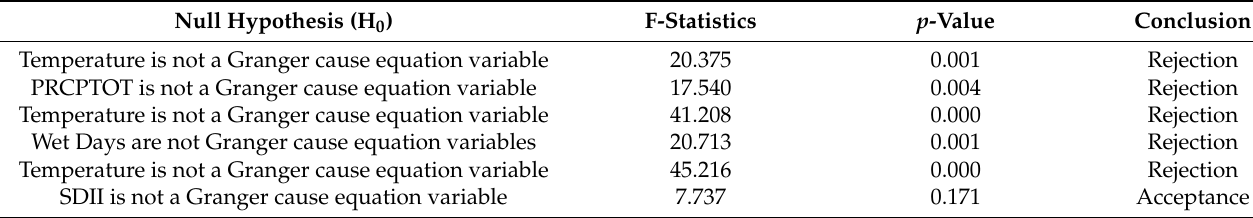
Table 4. Panel VAR Granger causality Wald test.